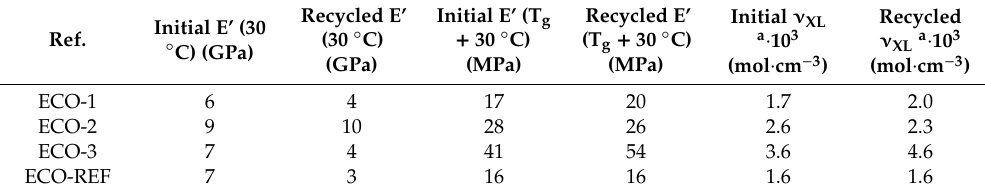
Table 6. Mechanical properties of the prepared vitrimers (pristine and recycled). Ref.